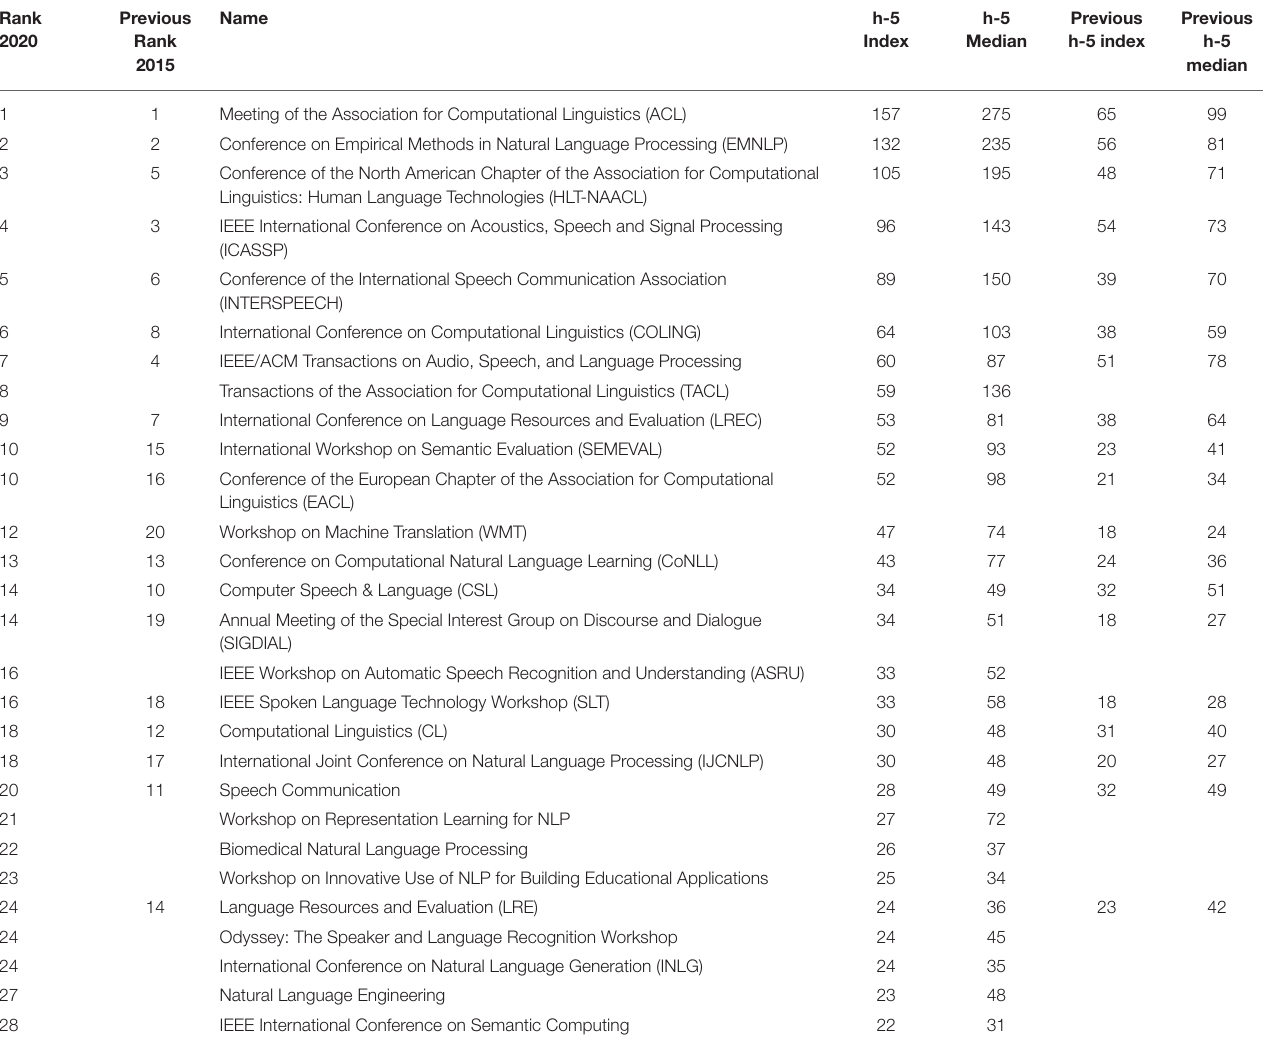
TABLE 20 | Ranking of 28 top sources according to Google Scholar h5-index over the past 5 years (2016–2020) a , in comparison with the previous ranking over